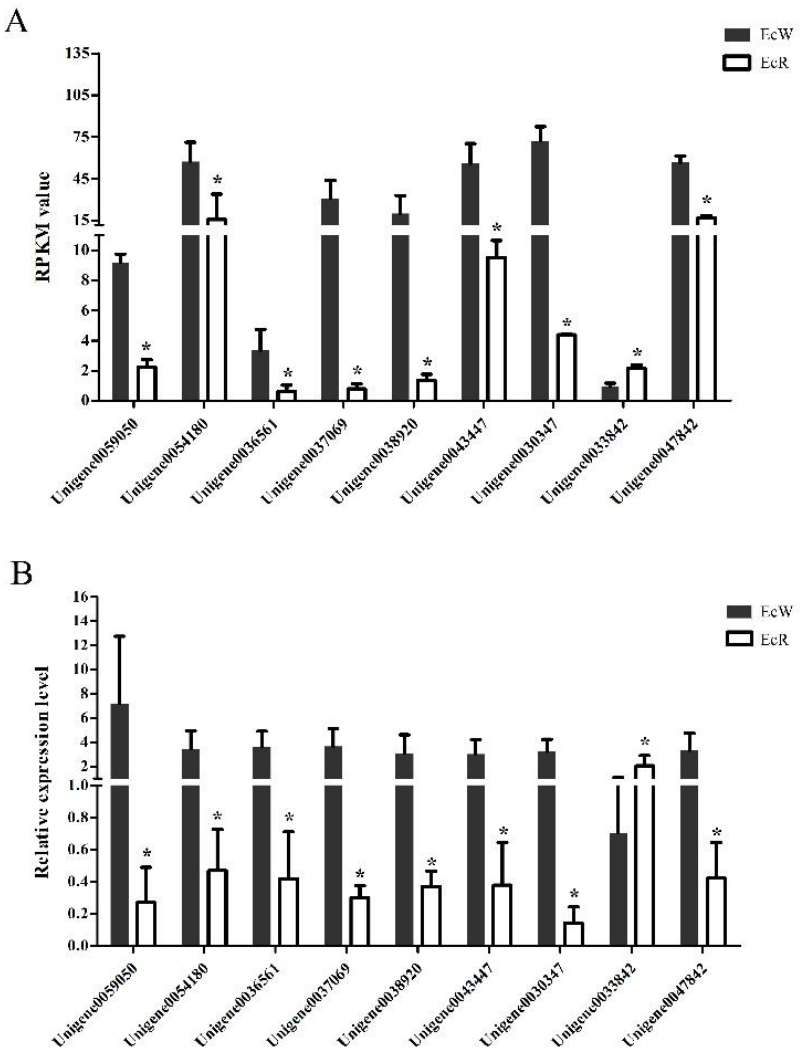
Figure 1. Expression profiles of nine selected unigenes between EcR and EcW prawns. The x -axis represents the names of selected unigenes. Columns represent the RPKM value from the transcriptome result ( A ) and the means of relative expression levels from the qPCR result ( B ). The significant difference in the expression levels between the EcR group and the EcW group was labeled with asterisks (*) at p < 0.05.